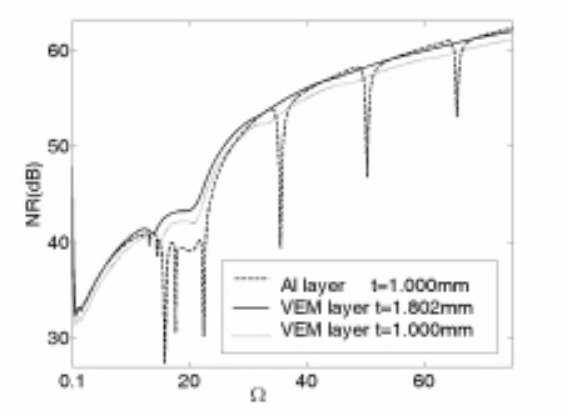
Fig. 7. Noise reduction of the aluminum cylinders with the thickness of 3 mm and a/b = 0.994 with various internal